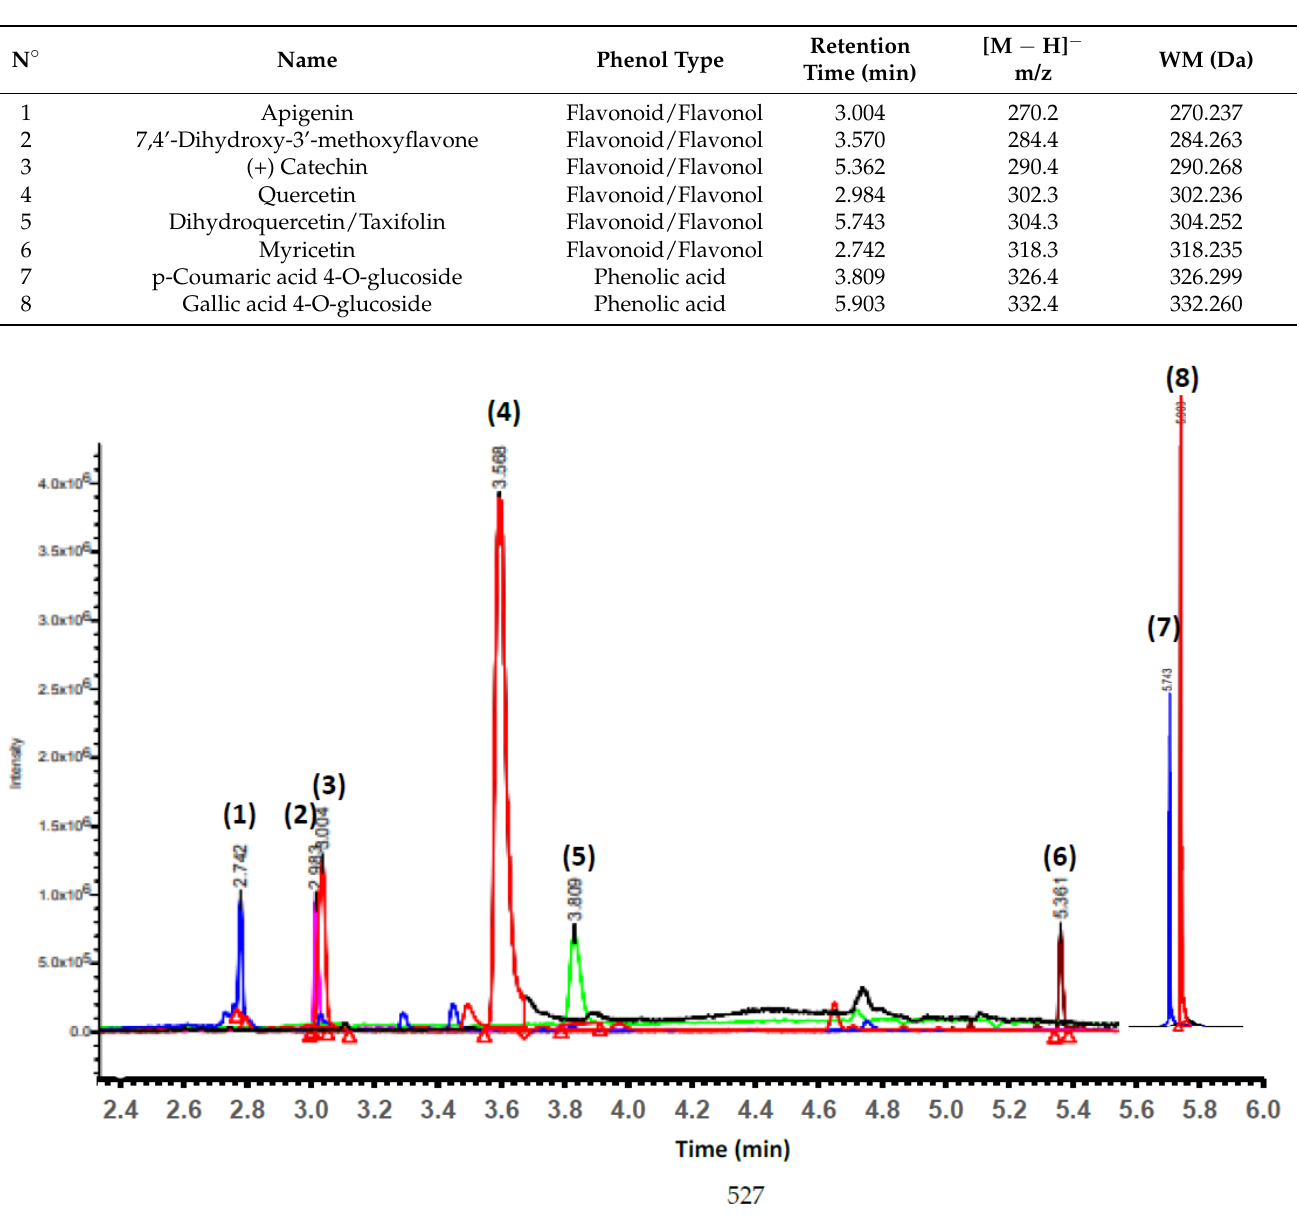
Table 3. Identification of phenolic components of PCF, PCPCs and their hydrolysates (GH25, DH25, GH35 and DH35).